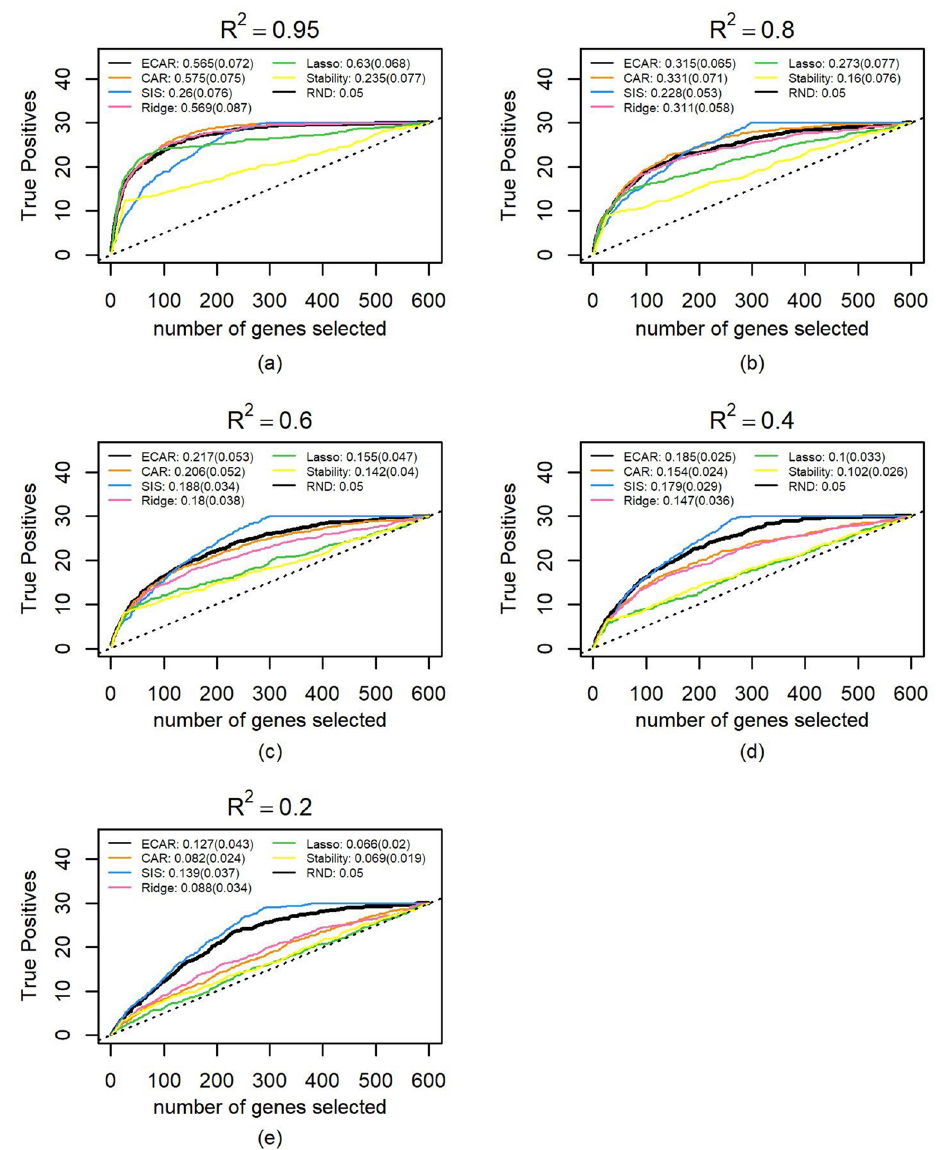
Figure 3. Comparison of feature selection performance on 500 simulated datasets. The median number of true positive variables as a function of the total number of selected genes as well as the median of PR-AUC and its standard deviation are shown for ECAR, CAR, SIS, ridge, lasso and stability selection under five R 2 scenarios. The total number of influential genes is 30, which are randomly selected from the first 300 genes (first block). Parameter α of ECAR is estimated using the methods described in the Methods section. The regularization parameter of ridge and lasso is estimated using fivefold cross-validation and generalized cross-validation, respectively. As lasso cannot select more variables than the sample size, we let it choose genes randomly when all genes in the output selected set are chosen. ( a ) R 2 is controlled at 0.95 for the 100 simulated datasets. ( b ) same as ( a ), R 2 controlled at 0.8. ( c ) Same as a, R 2 controlled at 0.6. ( d ) same as ( a ), R 2 controlled at 0.4. ( e ) Same as a , R 2 controlled at